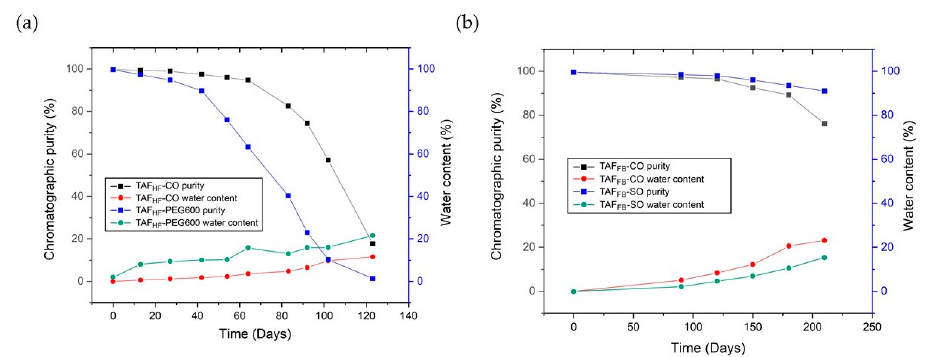
Figure 5. TAF purity and water uptake for the TAF HF implants ( a ) and TAF FB implants ( b ) as a function of time.